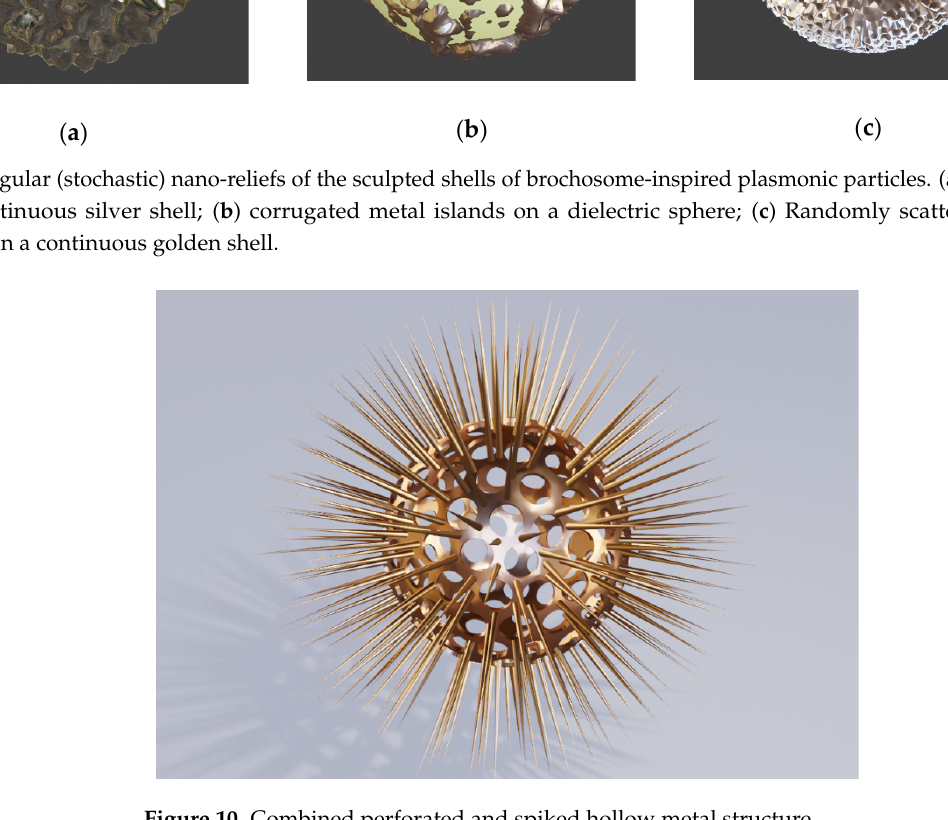
Figure 10. Combined perforated and spiked hollow metal structure.